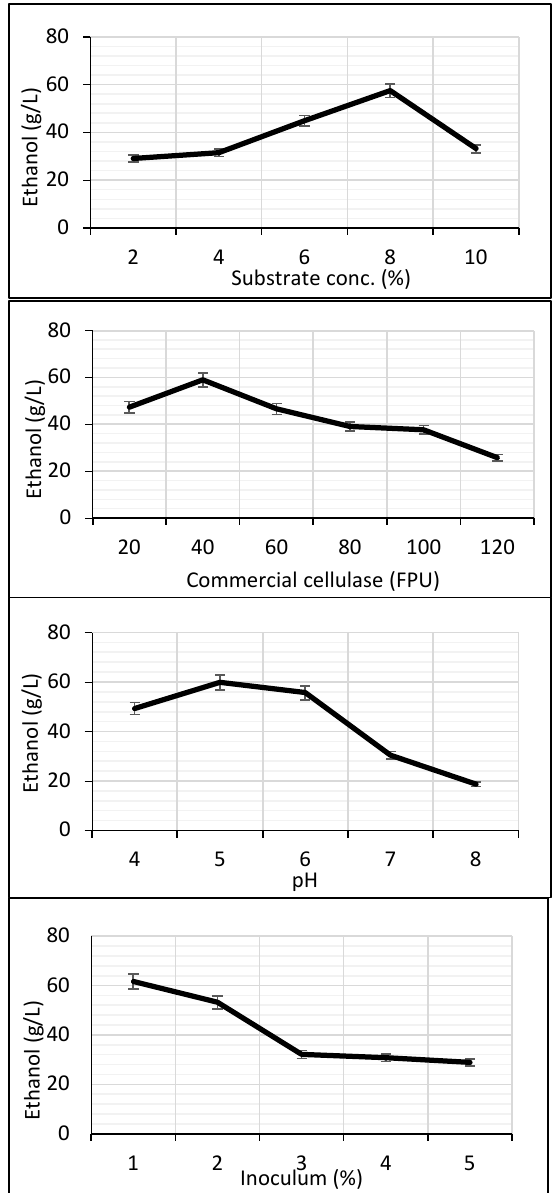
Figure 10. Optimization of physical parameters for ethanol production in SSF after 96 h.